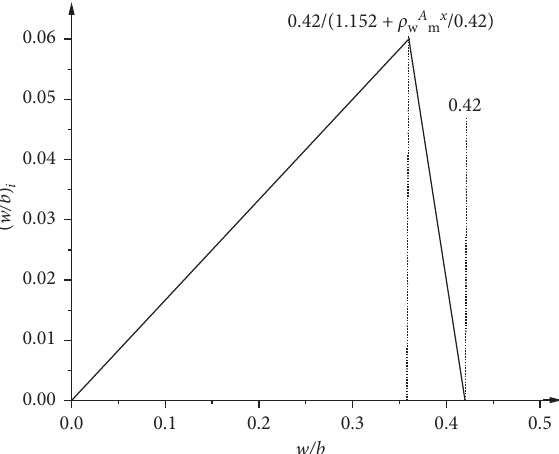
Figure 2: Minimum amount of IC water needed to obtain α